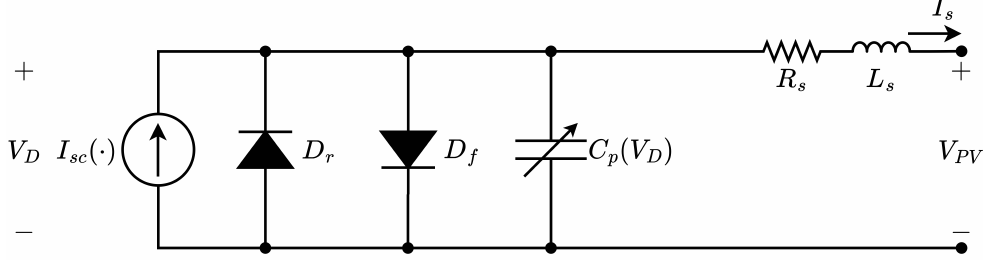
Figure 9. Circuit schematic of the proposed full circuit PV model (FCPVM). Developed from [18].